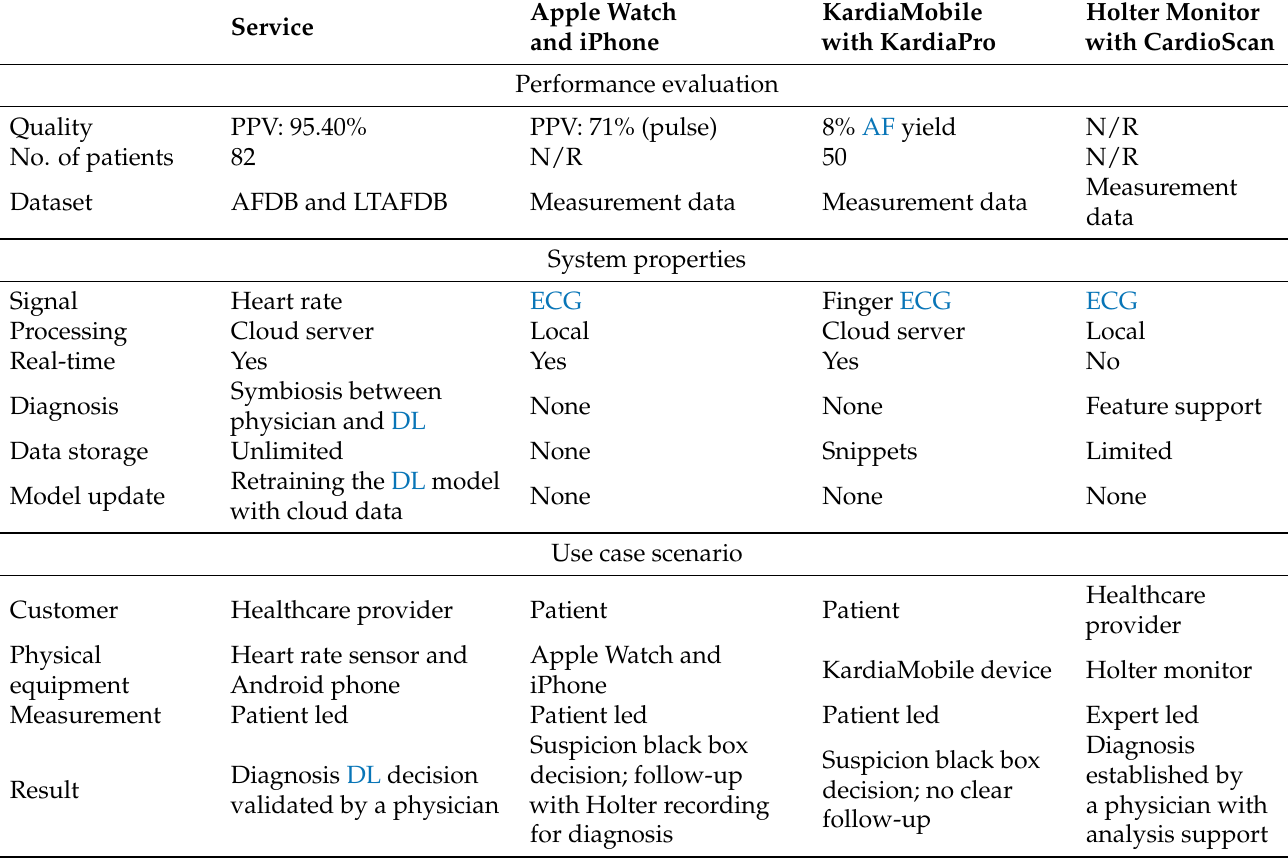
Table 4. Comparison of the AF detection service with three main